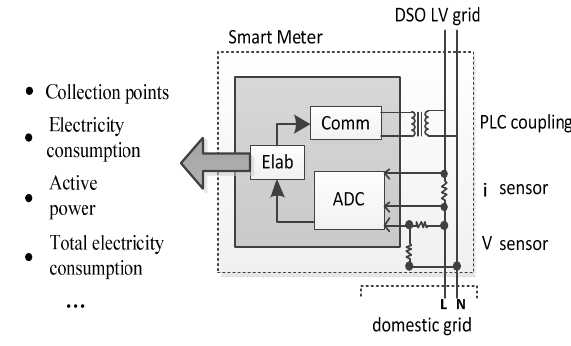
Figure 3. The internal structure of the smart meter.